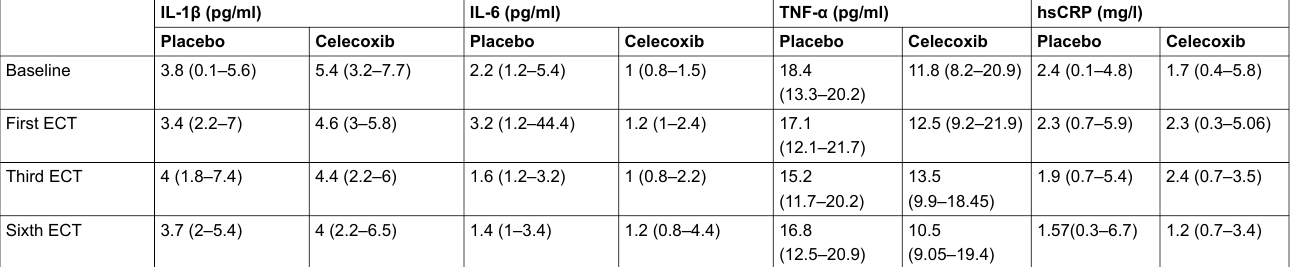
Table 3: Median and interquartile range (IQR) of serum cytokines and hsCRP concentrations in the celecoxib group (n = 25) and placebo group (n = 23) at each assessment. IL-1β (pg/ml) Placebo Celecoxib